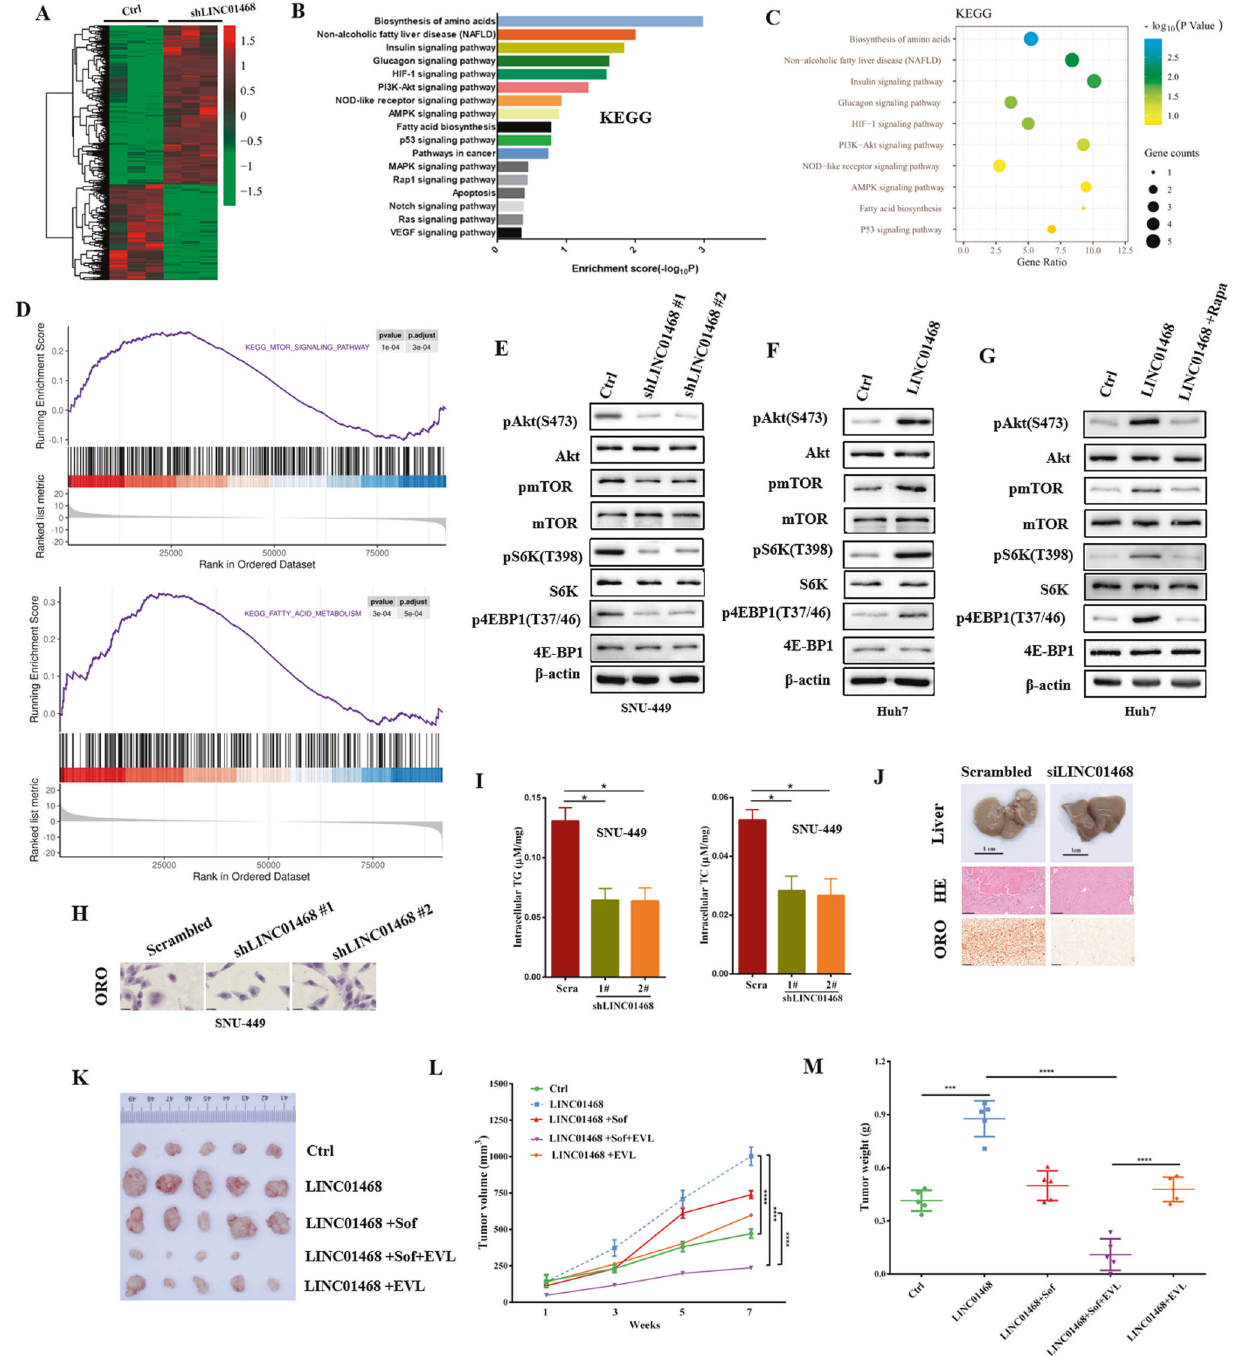
Fig. 3 LINC01468 activates Akt/mTOR signaling pathway. A Differently expressed genes in SNU-449 cells transfected with shLINC01468 or control were shown by heatmap. B KEGG pathway analysis of LINC01468-regulated genes. C KEGG pathway enrichment analysis of target genes by a bubble chart. The size and color of the dots represents the number and level of genes that were enriched in the corresponding pathways, respectively. D The item was enriched using GSEA in SUN-449 cells transfected with shLINC01468 or control. E , F Immunoblot detection of Akt/mTOR signaling pathway protein level in E LINC01468-knockdown SNU-449 cells or F LINC01468-overexpressed Huh7 cells. G Immunoblotting of the indicated protein lysates from Huh7 cells expressing Ctrl or LINC01468 treated with or without rapamycin (Rapa). H The intracellular lipid droplets in SUN-449 cells transfected with shLINC01468 or control were stained with oil red O. I The cellular content of triglycerides and phospholipids in the indicated cells in H was detected. J Representative liver images (top), H&E staining (middle), and ORO staining (bottom) of xenografts derived from SUN-449 cells stably transfected with the scrambled control or siLINC01468. K – M Overexpression of LINC01468 increased tumor growth and mediated sorafenib resistance of HCC tumors in nude mice. Images show representative tumor ( K ). Growth curves ( L ) and tumor weights ( M ) of mean ± SD of six mice in each group.*** P < 0.005; **** P < 0.001.